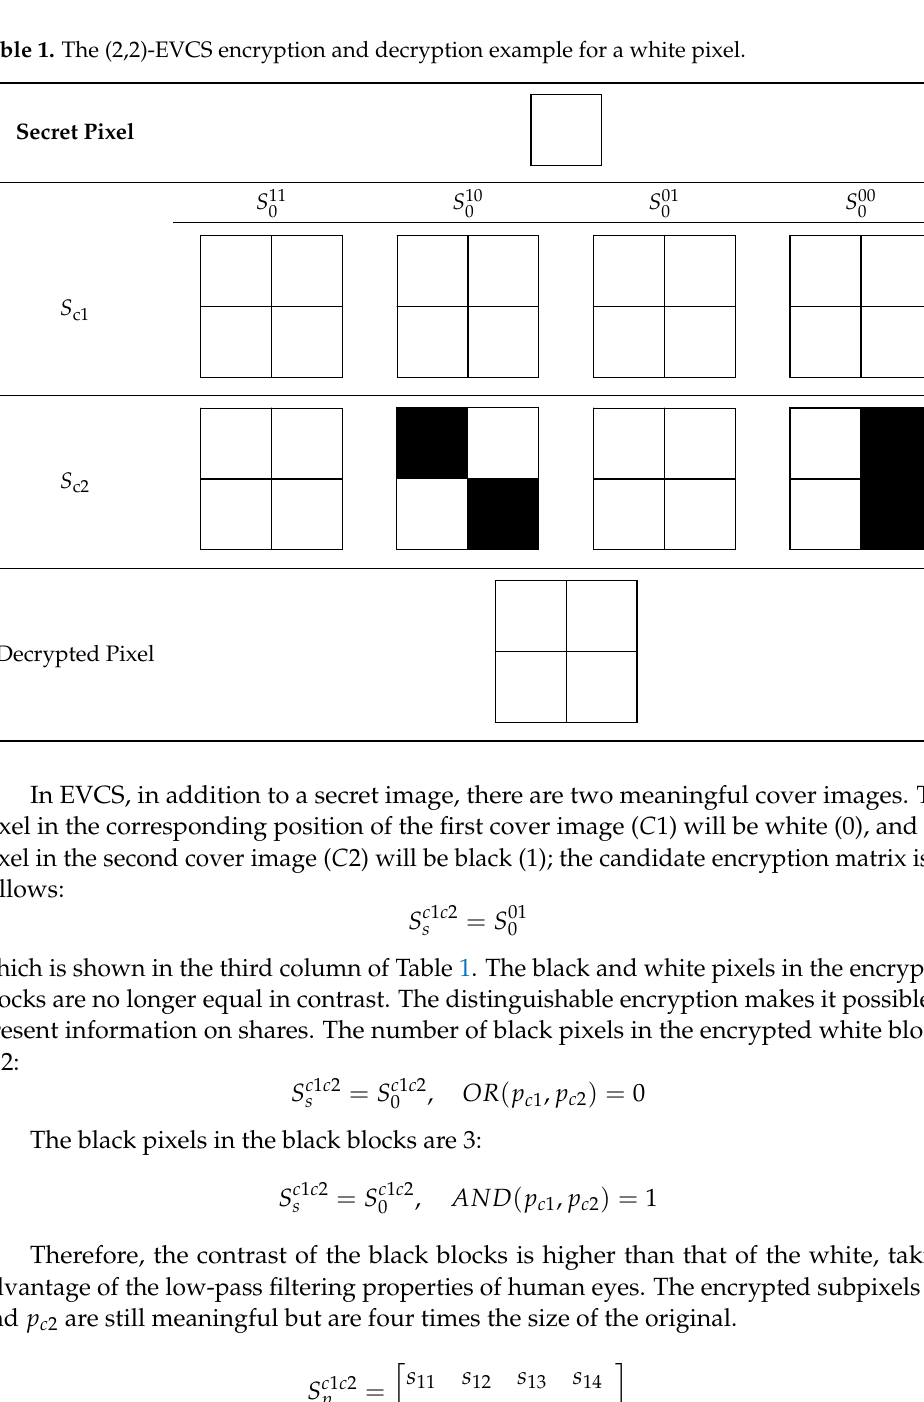
Secret Pixel Table 1. The (2,2)-EVCS encryption and decryption example for a white pixel.